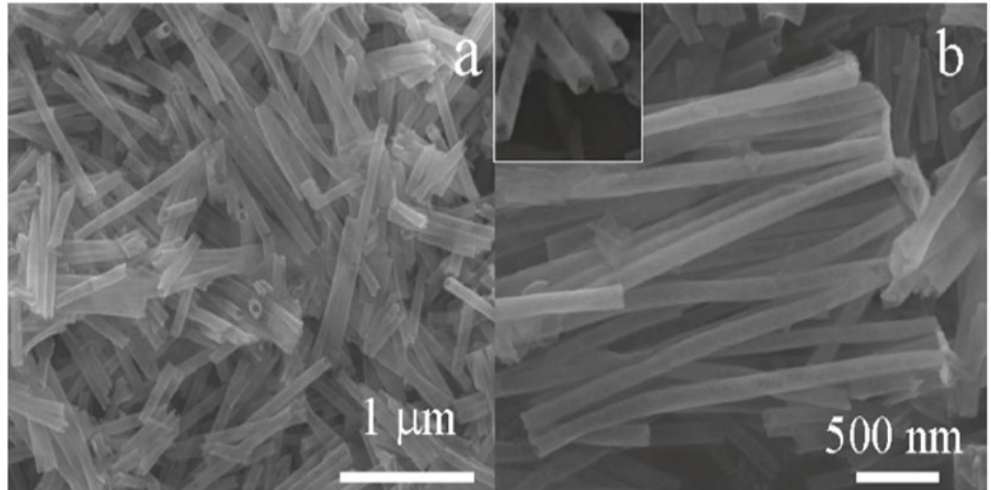
Figure 7. SEM images of the as-prepared SnO 2 nanotubes: ( a ) overview and ( b ) magnified image showing the open ends of nanotubes. (Reprinted with permission from [72]. Copyright 2011, American Chemical Society, Washington, DC, USA).